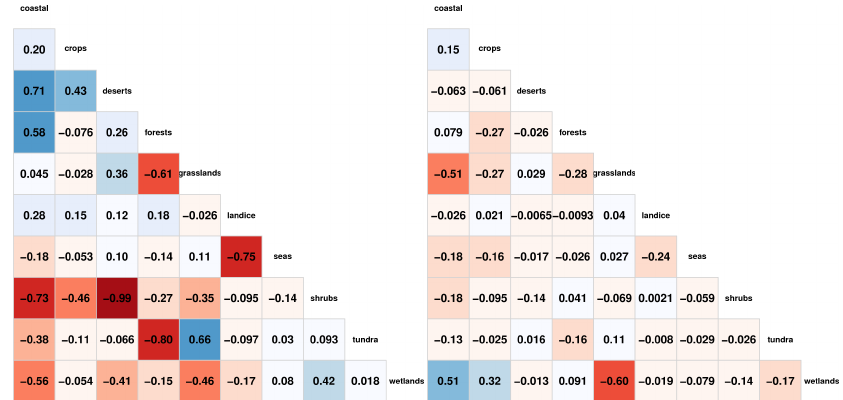
Fig. 4. Correlations between flux estimates for different ecosystems. Here for CCN-ACTIVE, 1µm particles. Left: NO-PRIOR inversion (with no prior constraint on fluxes). Right: PRIOR-POS inversion (with prior positivity constraint on fluxes). To aid visual interpretation, positive correlations are shaded blue and negative correlations are shaded red, with darker hues corresponding to greater absolute values.